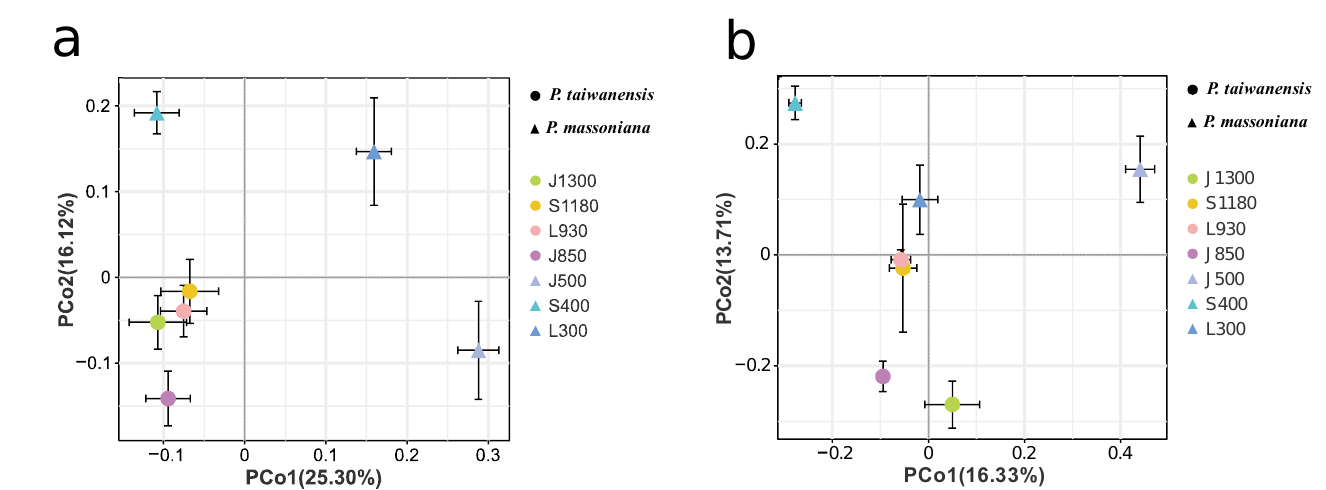
Figure 4. Principal coordinates analysis (PCoA) of bacterial ( a ) and fungal ( b ) communities in different forest soils at different elevations.